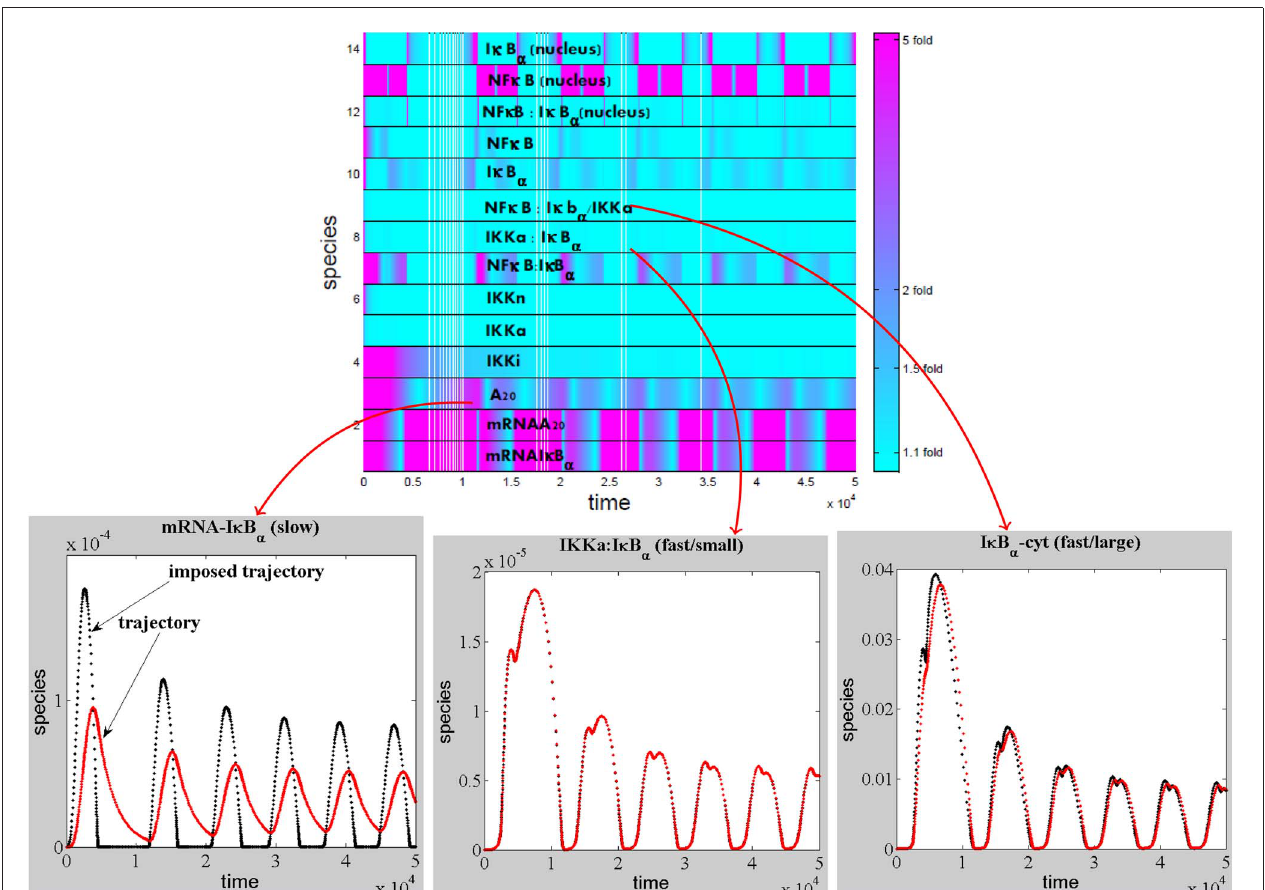
FIGURE 5 | Detection of the slaved species for a NF- κ B pathway model. The modulus of the log-ratio, | log ( c i ( t )/ c ∗ i ( t )) | , between actual and imposed trajectories has been calculated as a function of time for each species of the model of NF κ B canonical pathway (proposed in Lipniacki et al., 2004), model M ( 14 , 25 , 28 ) from Radulescu et al. (2008). If the modulus is close to zero